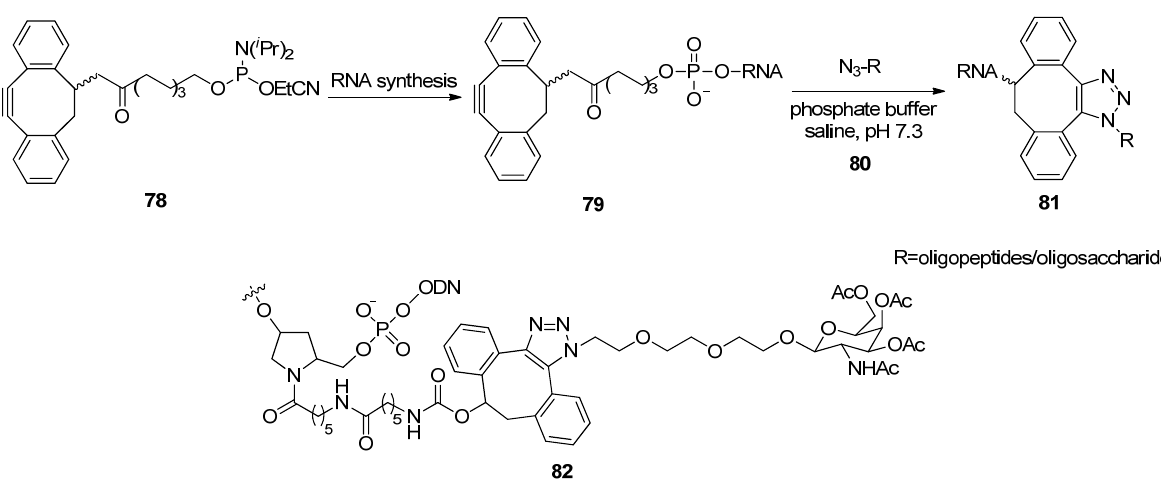
Figure 13. Synthesis and the structure of RNA conjugates via the SPAAC